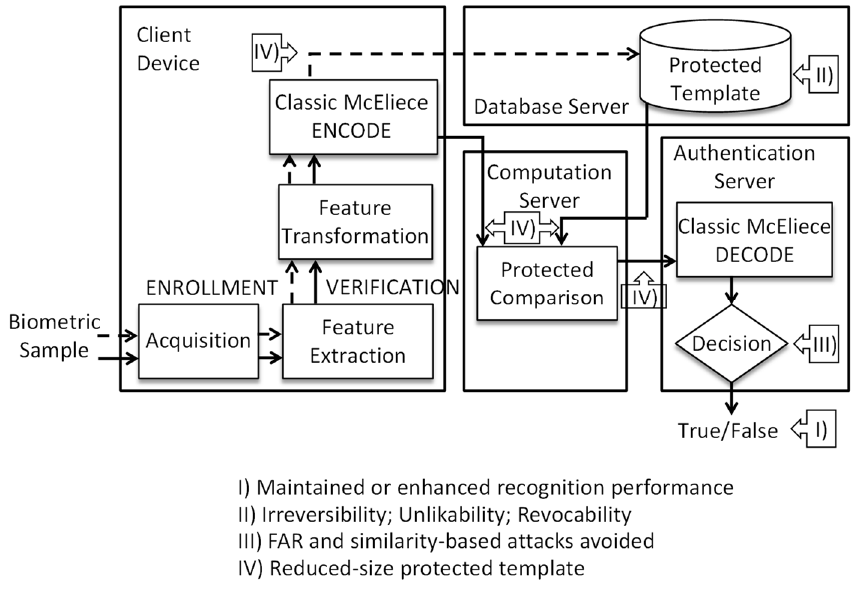
Figure 2. Overview of the proposal with the main contributions indicated.